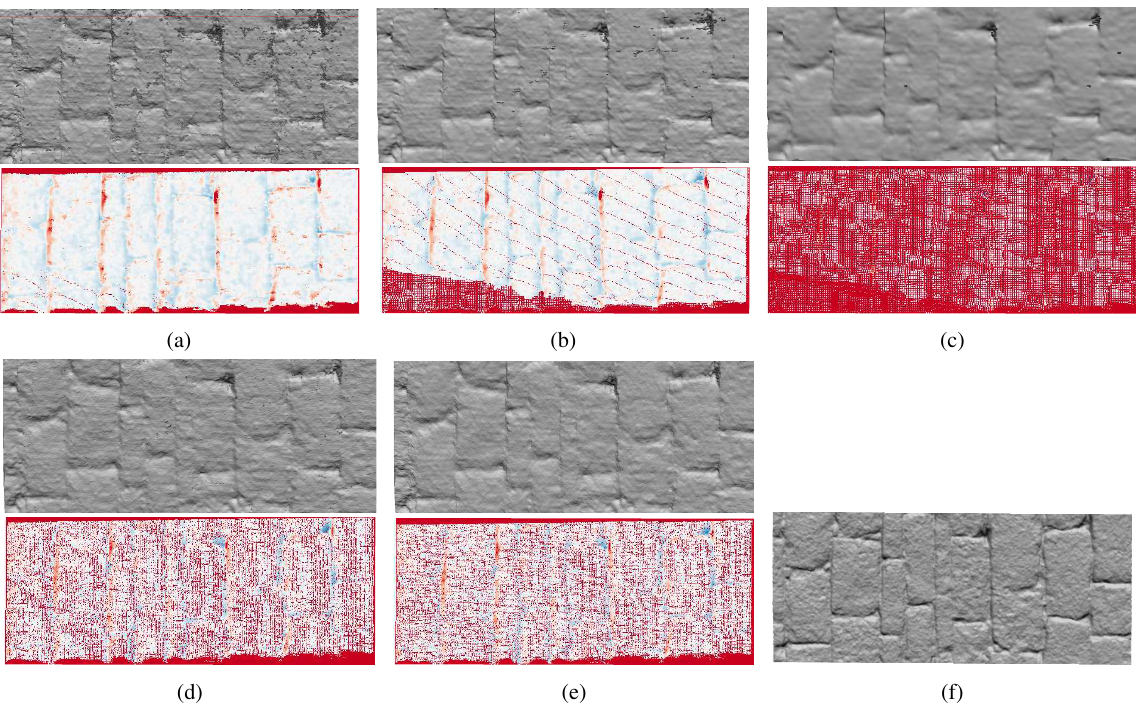
Figure 6: Meshes derived from filtered point clouds and differences of reprojected points to ground truth mesh (dark blue / dark red correspond to +5 / -5 GSD). (a)-(c): Results derived by (Fuhrmann and Goesele, 2011) employing gsd-wise multipliers of 1, 2 and 4. (d) and (e): our approach with filtering along normals and in direction of line of sight. (f): ground truth.